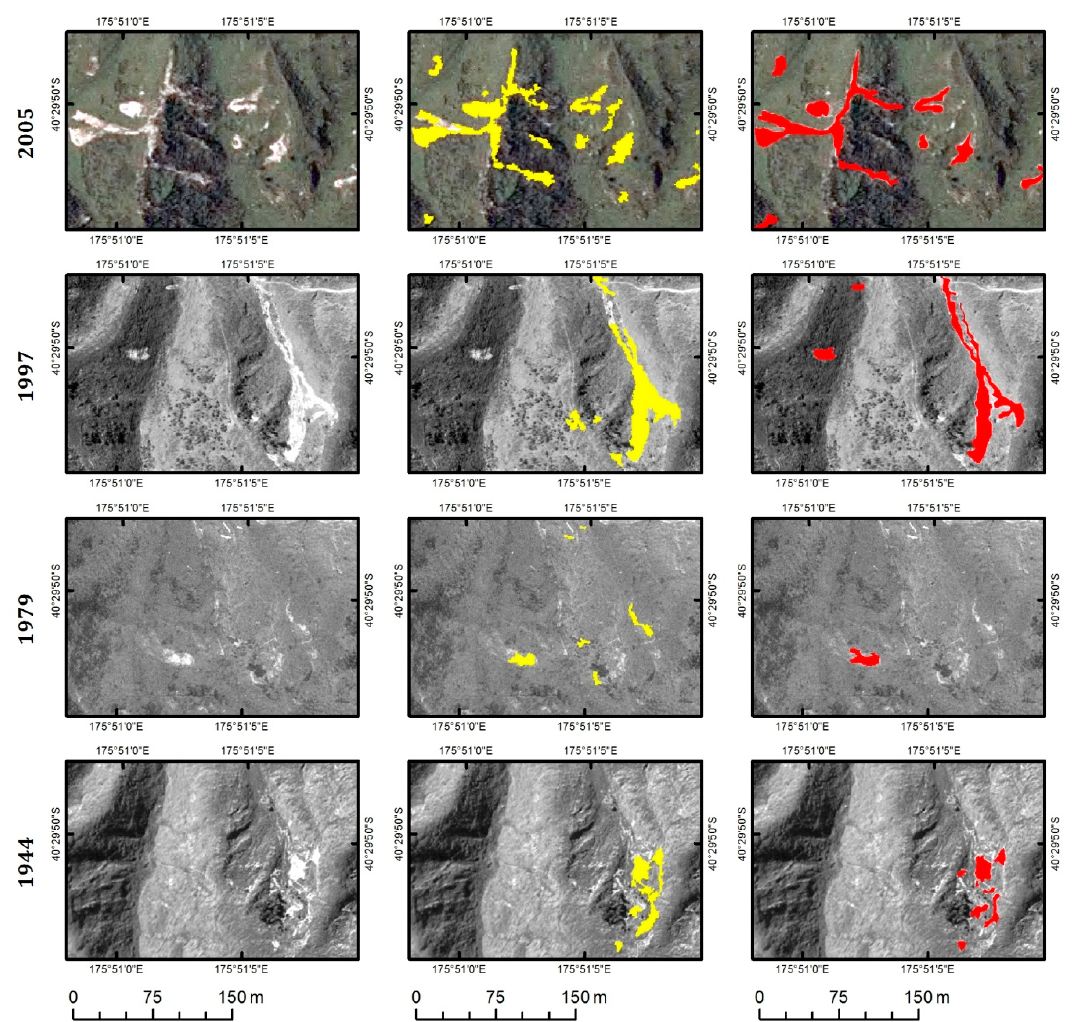
Figure 5. Subset from the southwestern part of the study area showing the aerial photographs ( left ), the OBIA ( middle ) and manual ( right ) landslide mapping results for each date. The figure shows how this sub-area is affected by landslides over time. Most landslides disappeared when comparing an aerial photography to the subsequent one, since vegetation started to grow again. The distribution of the detected landslides is very similar for both methods.